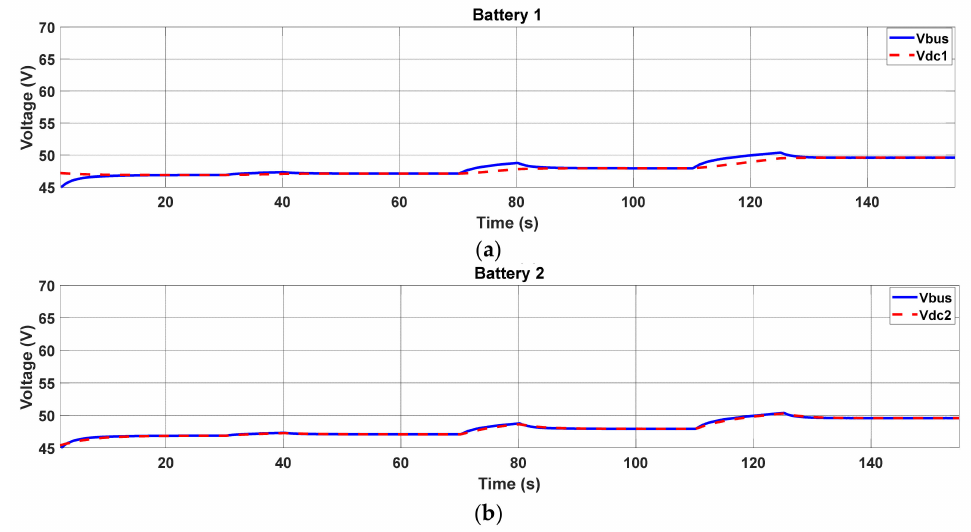
Figure 13. DC bus voltage control with conventional droop for ( a ) battery 1 and ( b ) battery 2 at a time of 155